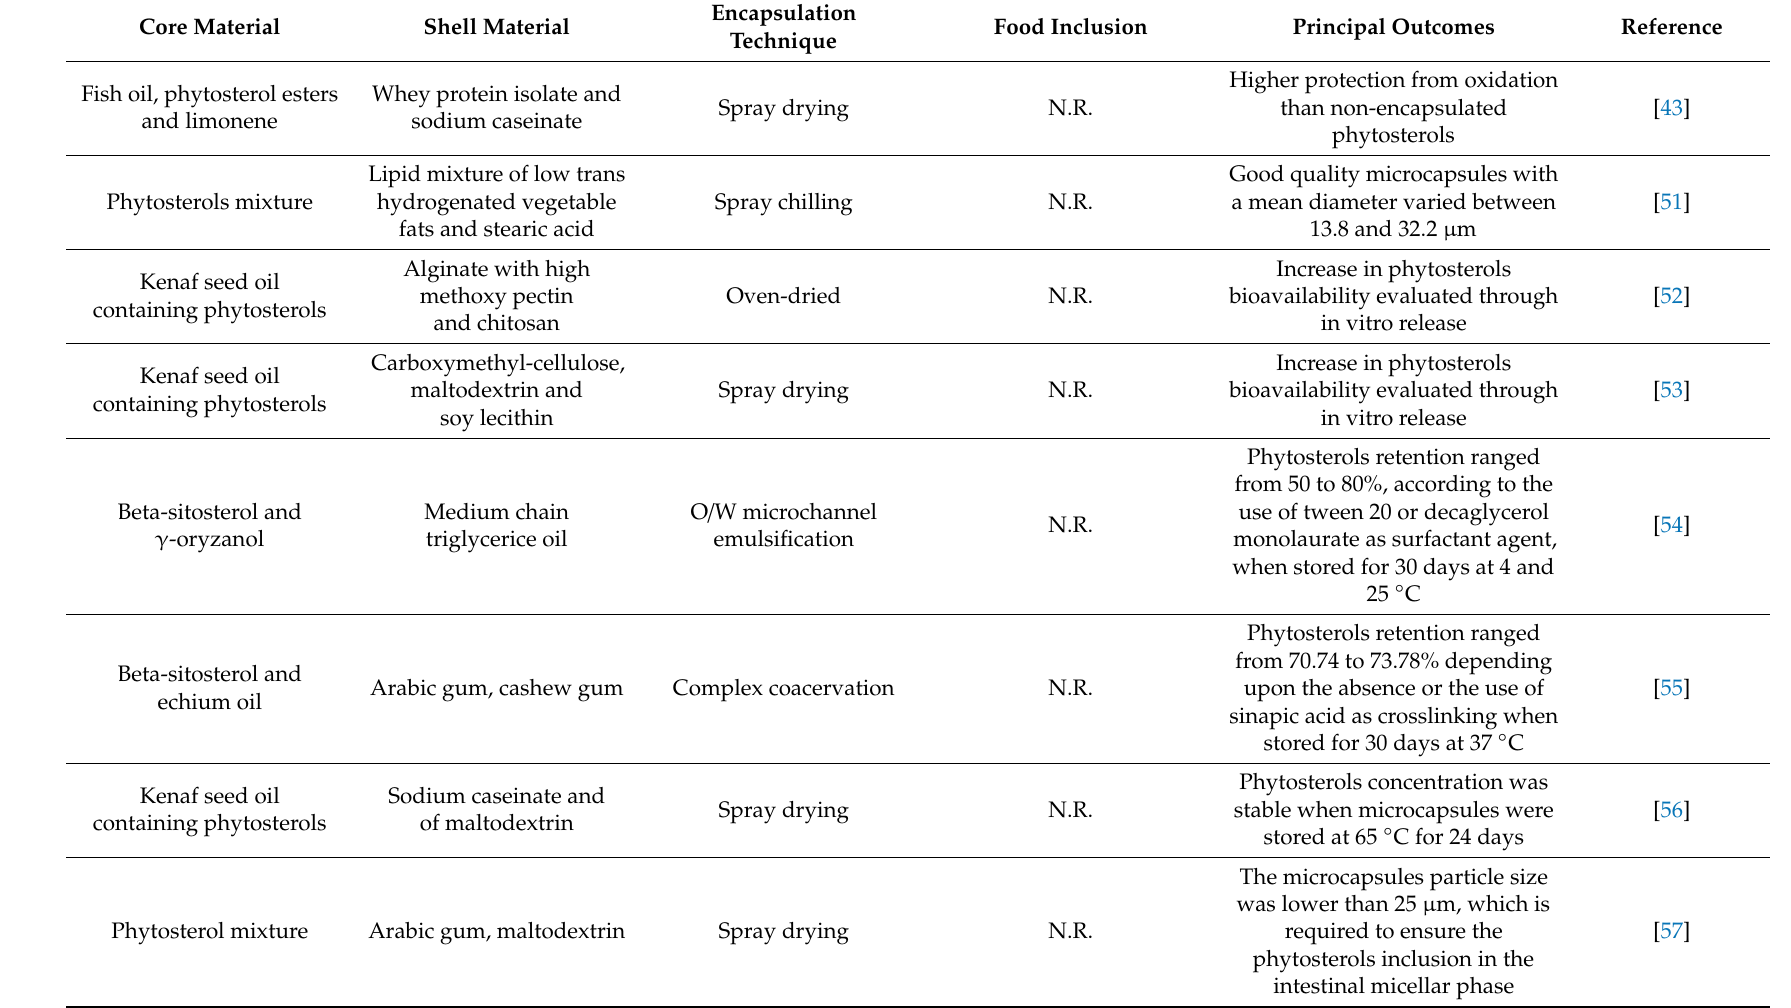
Table 2. Overview of microencapsulated phytosterols and their